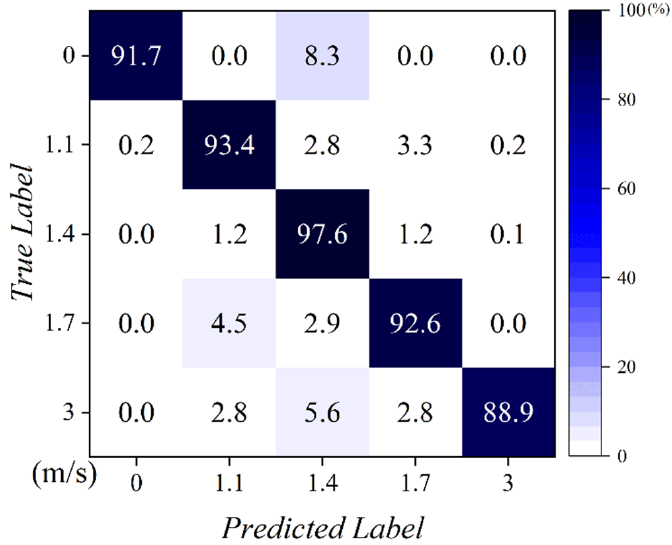
Figure 11. Moving speed estimation using LSTM-C.